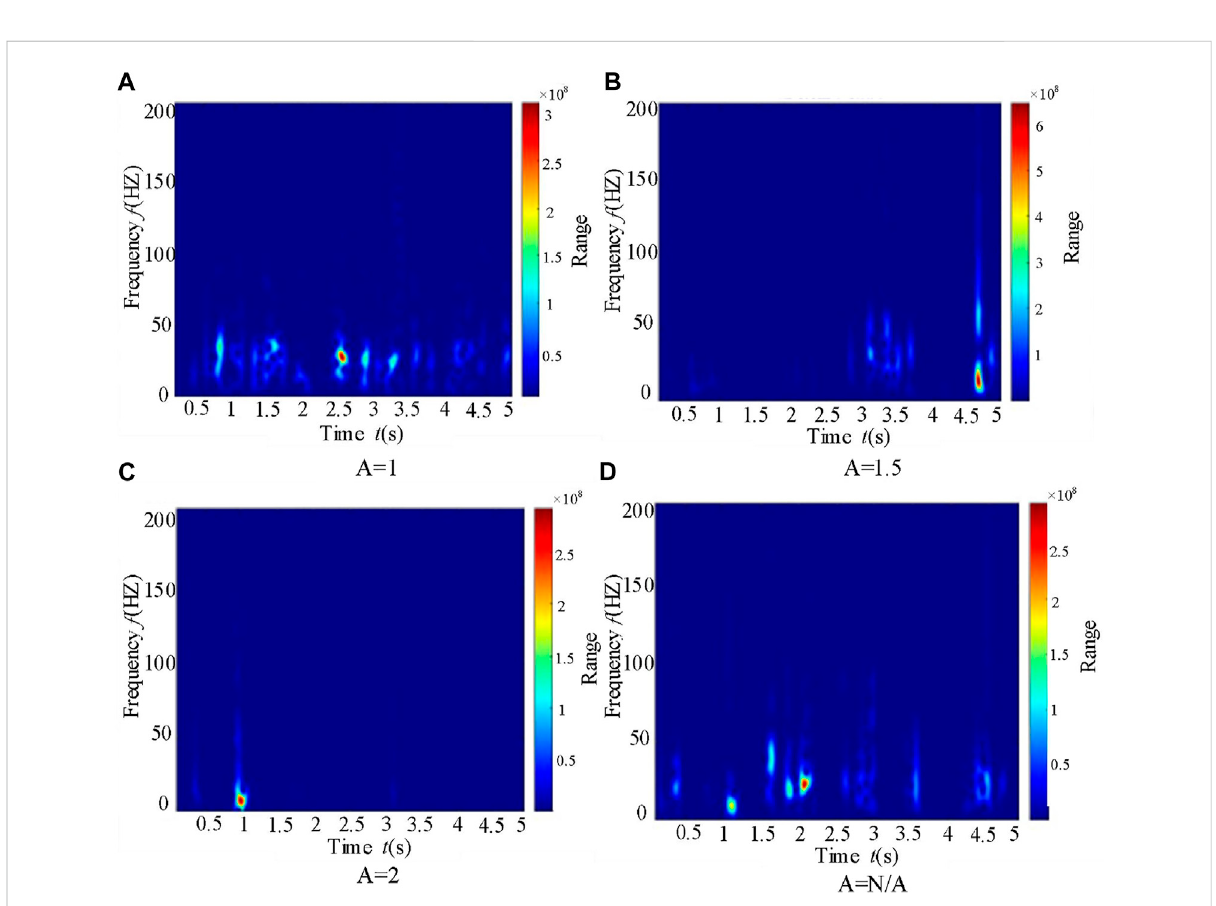
FIGURE 18 Time – frequency spectra of tail beam vibration with different particle